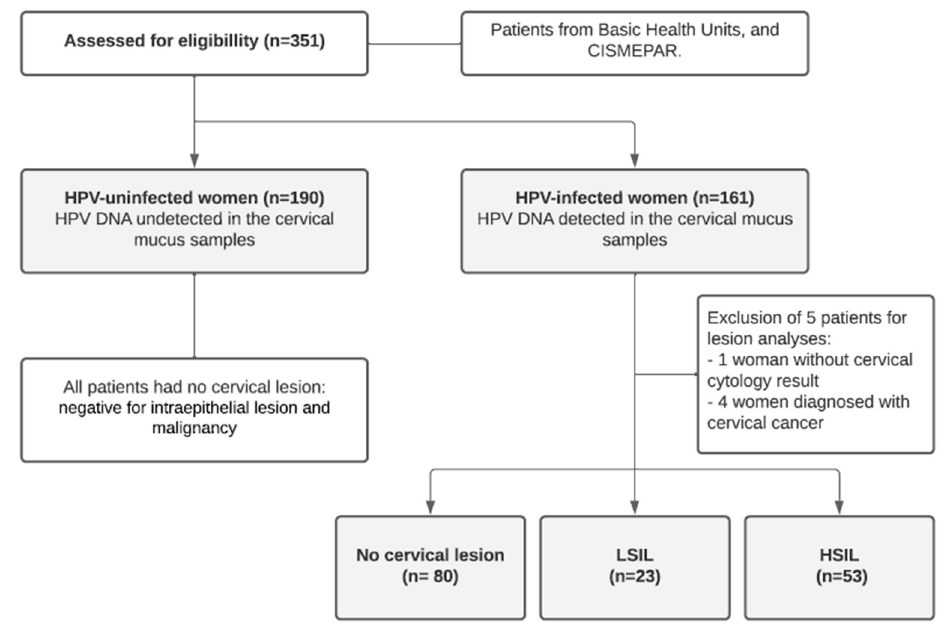
Figure 1. Study flow chart.